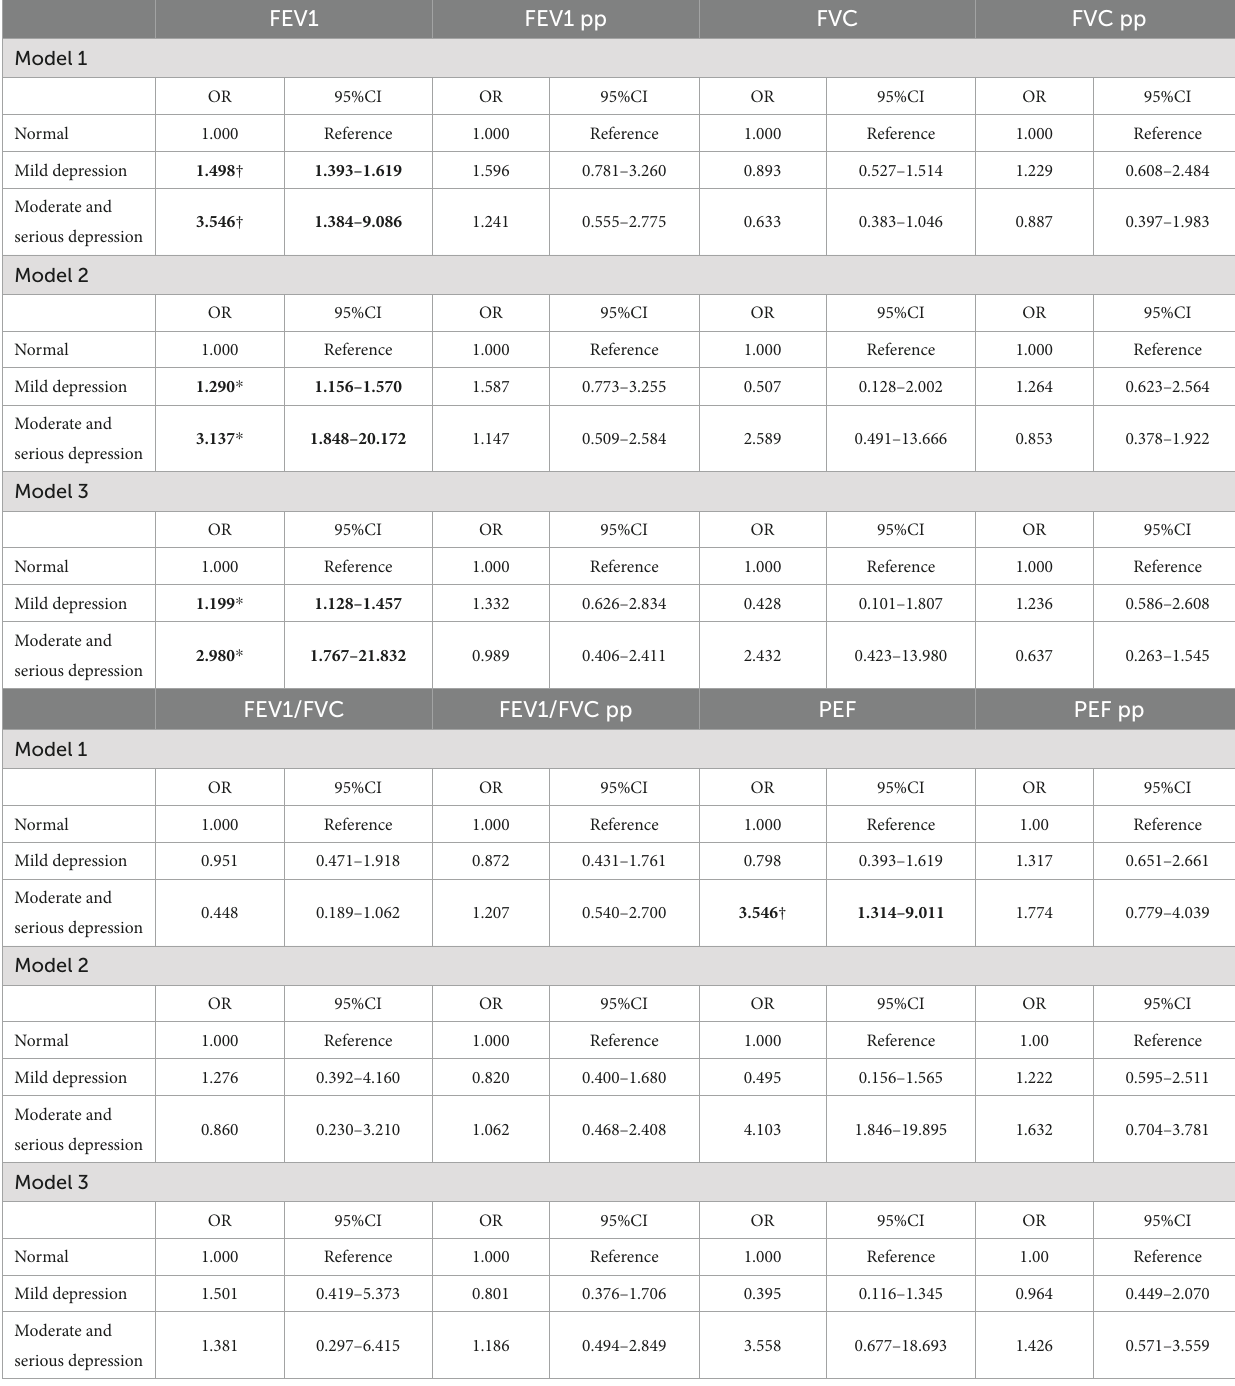
TABLE 3 Associations between level of depression and lung function among college students. FEV1 FEV1 pp FVC FVC